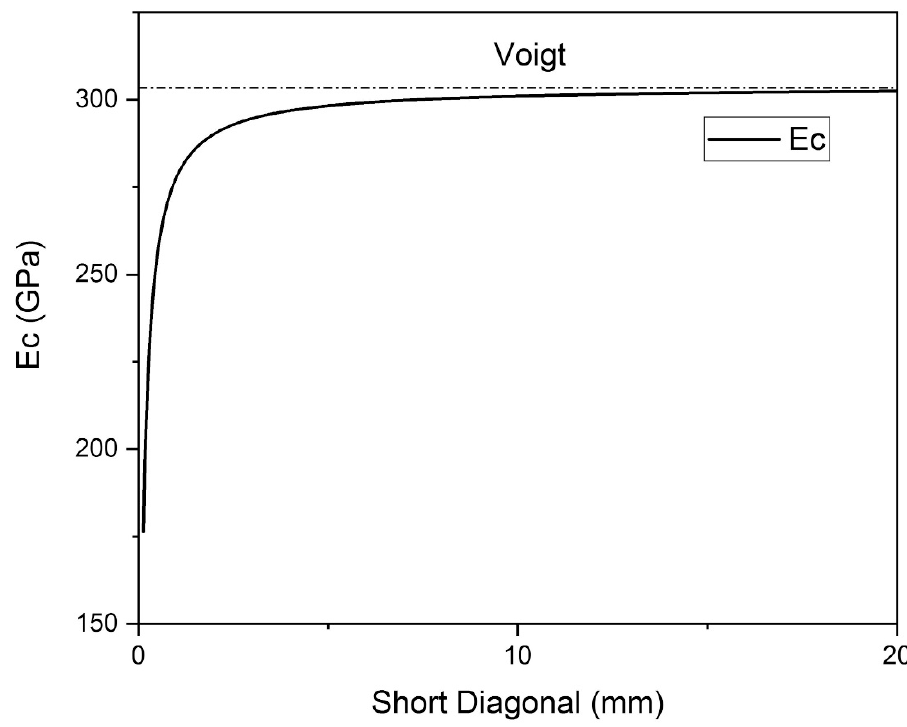
Figure 6. Carbon-Epoxy hexagonal composite stiffness.